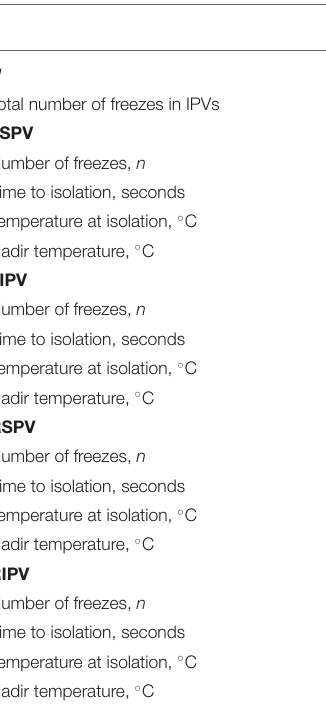
TABLE 3 | Procedural characteristics of CBA